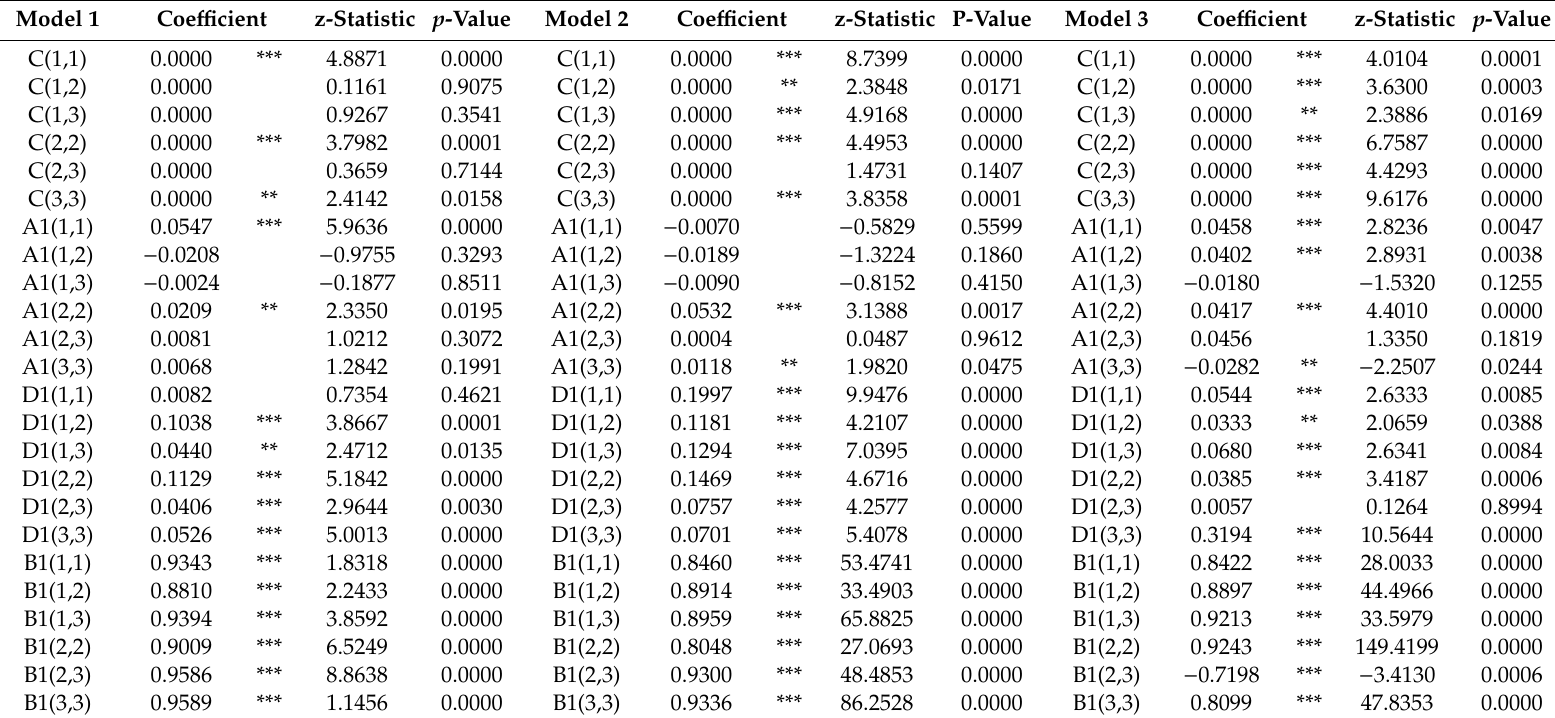
Table 2. Estimation results of asymmetric VAR–VECH–TARCH (1,1)